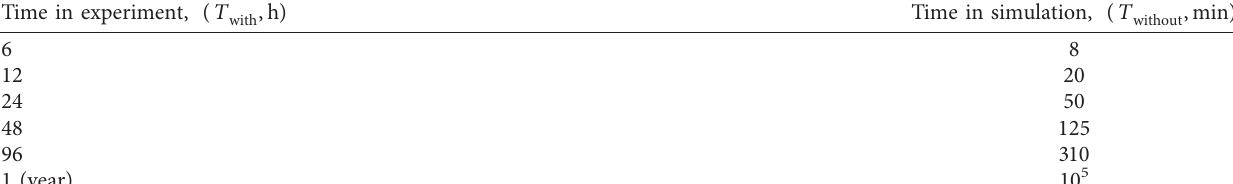
Table 2: Maturation time in experiment compared with time in numerical simulation to reach the same maturation state. , h Time in experiment, ( T with